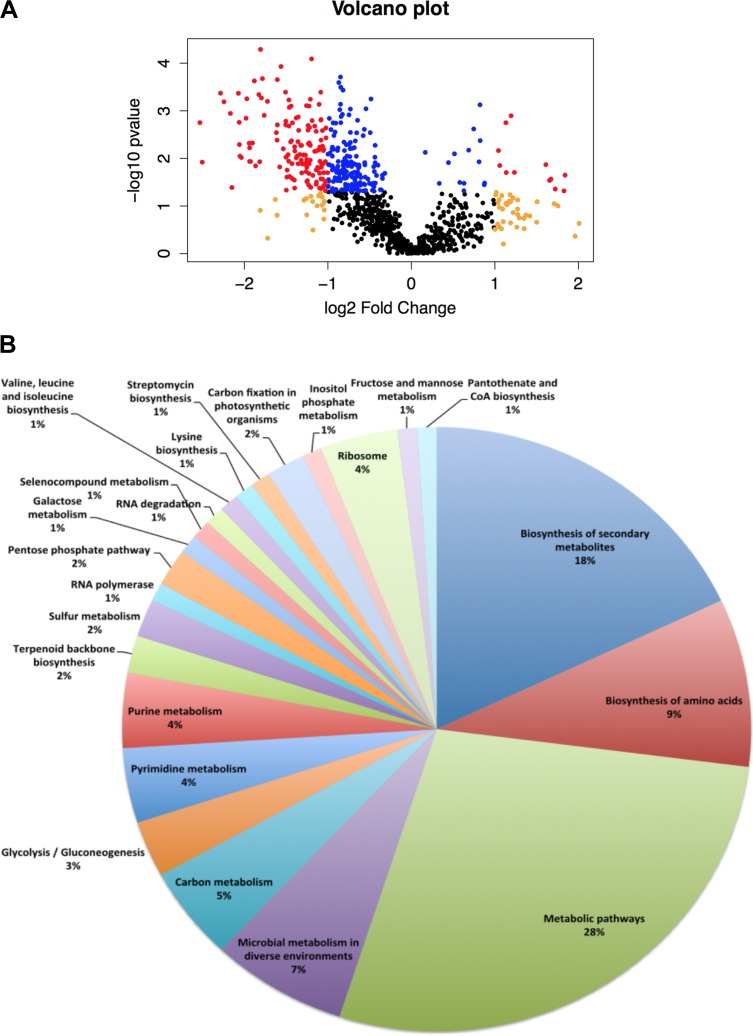
Analysis of the quantitative proteomic results. (A) Volcano plot showing the proteins. The proteins were indicated in color as follows: blue, fold change of <2, P value of <0.05; red, fold change of >2, P value of <0.05; yellow, fold change of >2, P value of >0.05. (B) Enrichment analysis. The 377 proteins significantly downregulated obtained by Progenesis were used for enrichment analysis in String 10 using default parameters. CoA, coenzyme A.